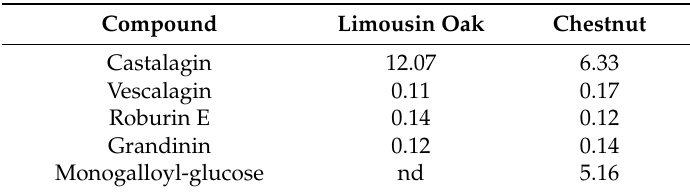
Table 4. Mean concentrations of hydrolysable tannins in wine spirits aged four years in different kinds of